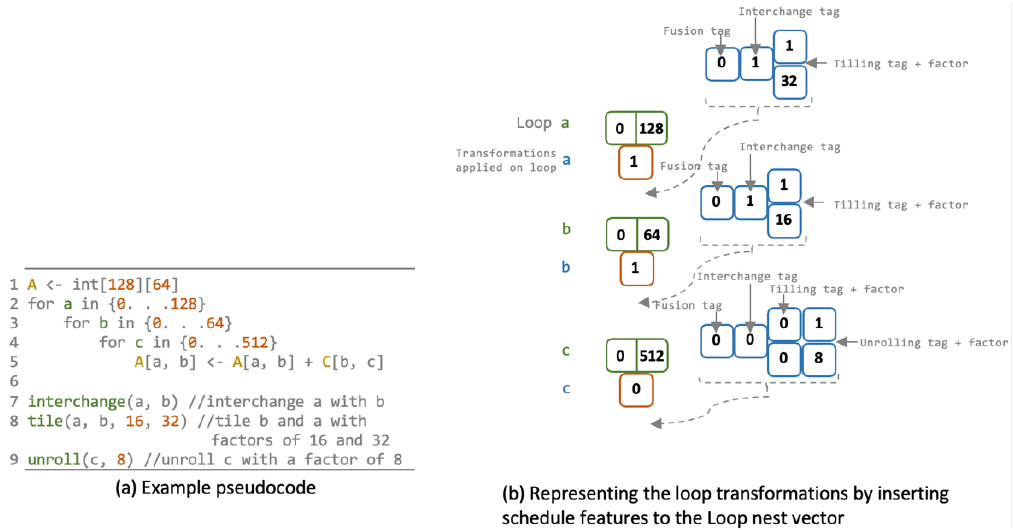
Figure 9. Loop nest optimization pseudocode and representation.